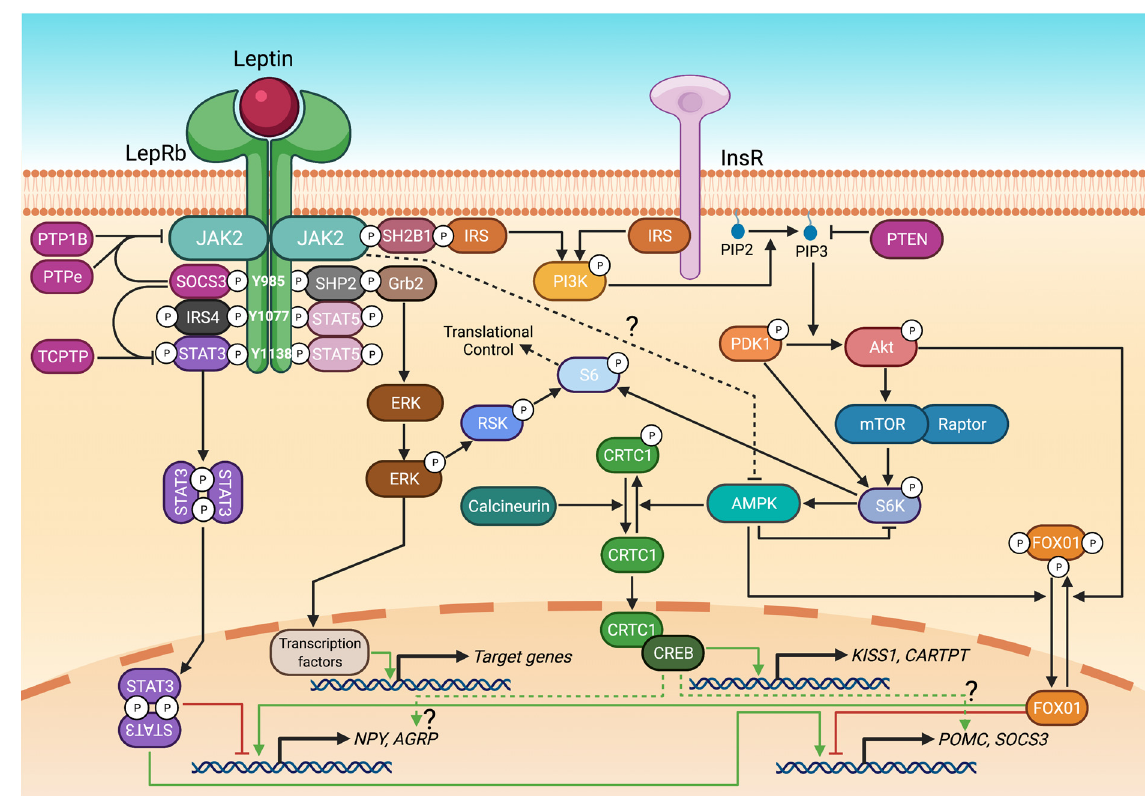
Figure 1. Summary of the major signalling pathways used by the LepRb in the hypothalamus to regulate metabolic and reproductive function. See text for explanatory details. AGRP, agouti-related peptide; Akt is also known as protein kinase B; AMPK, adenosine monophosphate-activated protein kinase; CARTPT, cocaine- and amphetamine-regulated transcript prepropeptide; CREB, cAMP response element binding protein; CRTC, CREB-regulated transcriptional coactivator; ERK, extracellular signal-regulated kinase; FOXO1, forkhead box protein O1; Grb2, growth factor receptor-bound protein 2; InsR, insulin receptor; IRS, insulin receptor substrate; IRS4, insulin receptor substrate 4; JAK2, Janus kinase 2; KISS1, kisspeptin gene; LepRb, long form of the leptin receptor; mTOR, mammalian target of rapamycin; NPY, neuropeptide Y; PDK1, phosphatidylinositol-dependent protein kinase 1; PI3K, phosphoinositide 3-kinase; PIP2, phosphatidylinositol 4,5- biphosphate; PIP3, phosphatidylinositol 3,4,5-triphosphate; POMC, pro-opiomelanocortin; PTEN, phosphatase and tensin homolog deleted on chromosome 10; PTP1B, protein tyrosine phosphatase 1B; PTPe, protein tyrosine phosphatase epsilon; RSK, p90 ribosomal S6 kinase; S6, ribosomal protein S6; S6K, p70 S6 kinase; SHP2, Src homology-2 domain-containing protein tyrosine phosphatase-2; SH2B1, Src homology-2 B adaptor protein 1; SOCS3, suppressor of cytokine signalling 3; STAT3 and STAT5, signal transducer and activator of transcript 3 and 5; TCPTP, T cell protein tyrosine phosphatase. The ‘?’ indicates a pathway for which there is only limited published